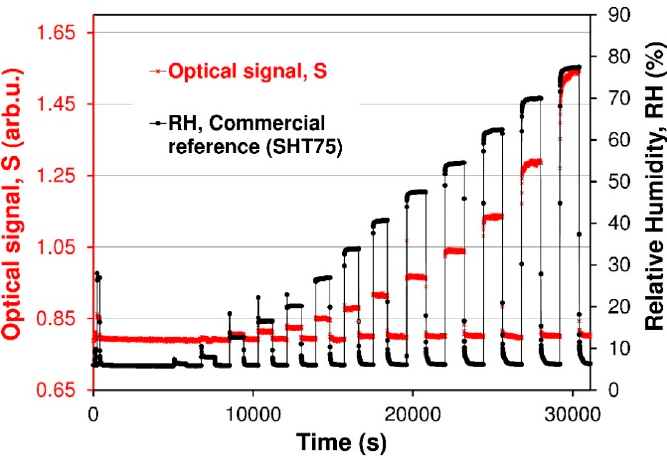
Figure 13. Optical response signal S vs. time of FPI sensor.